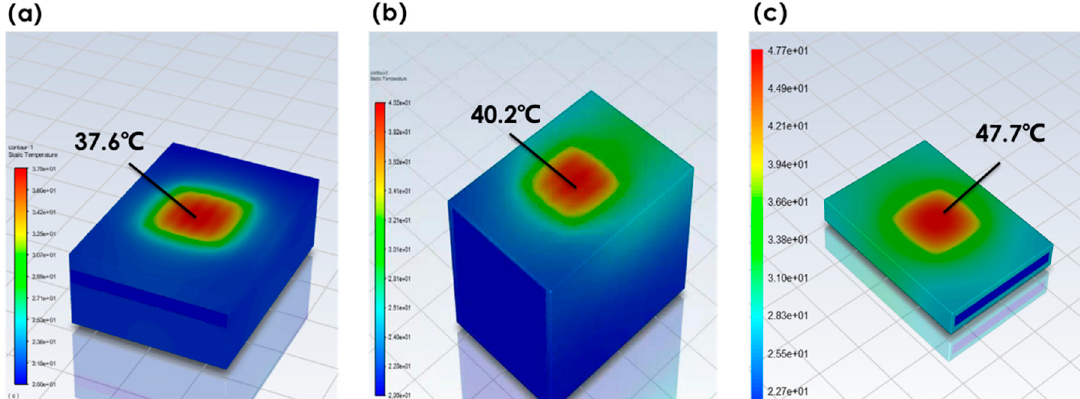
Figure 7. ( a ) Temperature cloud map of double-layer reflux microchannel. ( b ) Temperature cloud map of honeycomb microchannel. ( c ) Temperature cloud map of pin-finned microchannel.